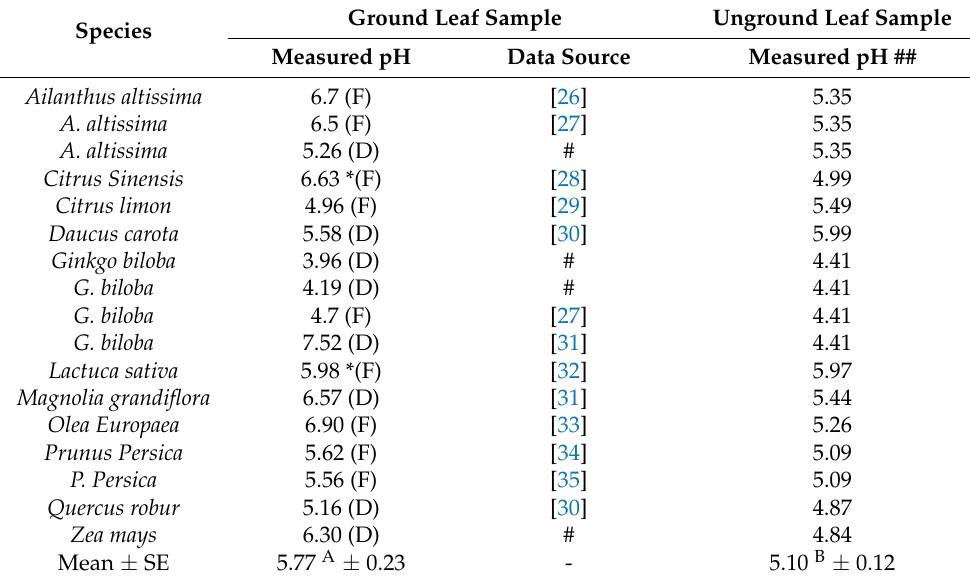
Table 2. Comparison of leaf pH measured for the same plant species with ground and unground samples based on published literature and our